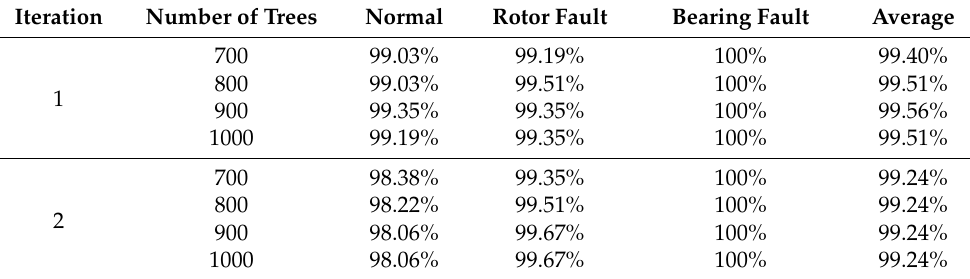
Table 8. Diagnostic accuracy of gradient boosting machine for cross-validation.